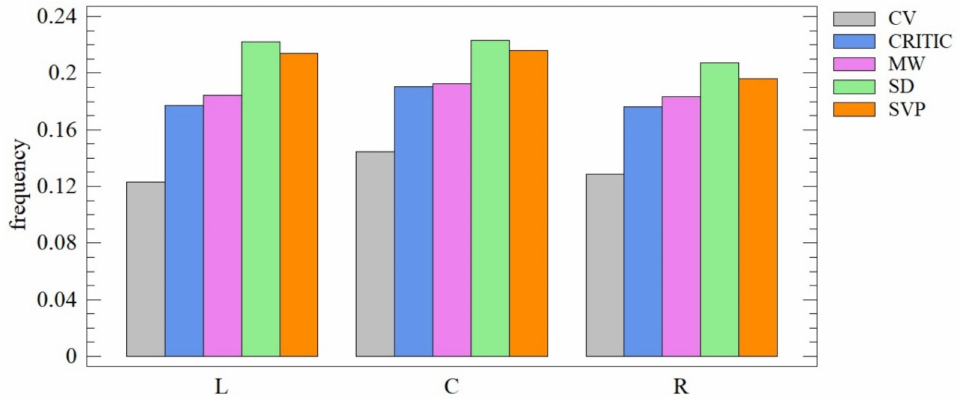
Figure 12. Box plot of results obtained by player position (TOPSIS combined with CV, CRITIC, MW, SD and